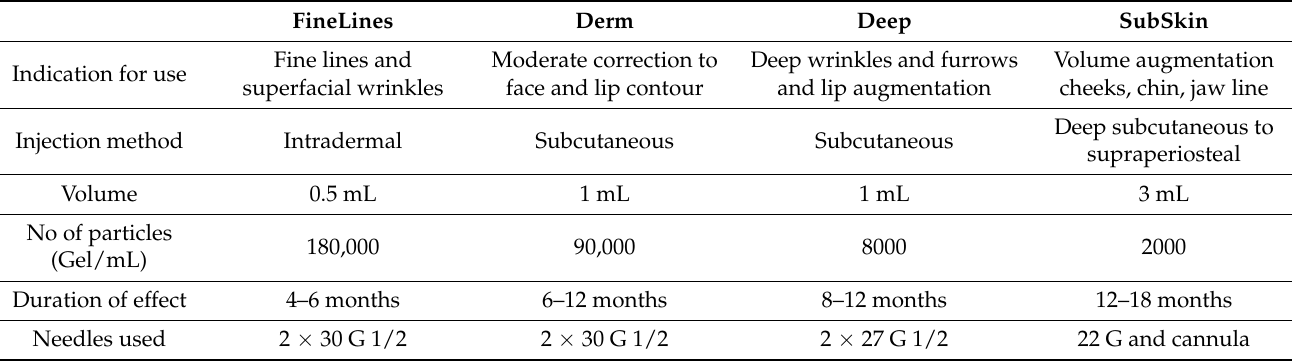
Table 8. Product description of Perfectha ® Hyaluronic Acid dermal